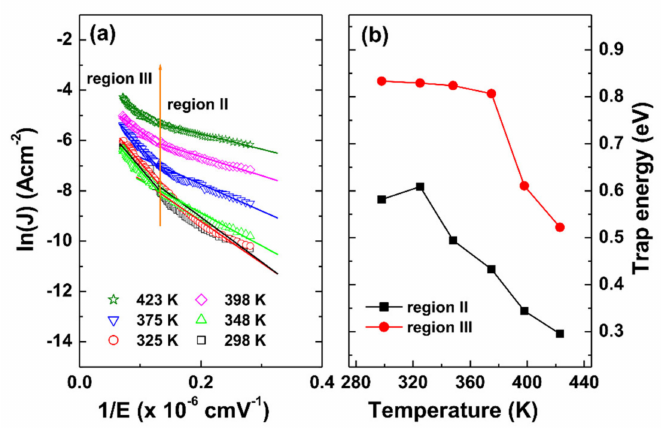
Figure 5. ( a ) Trap assisted tunneling (TAT) plots of ln( J ) vs. 1 / E and ( b ) the obtained trap energy for sample